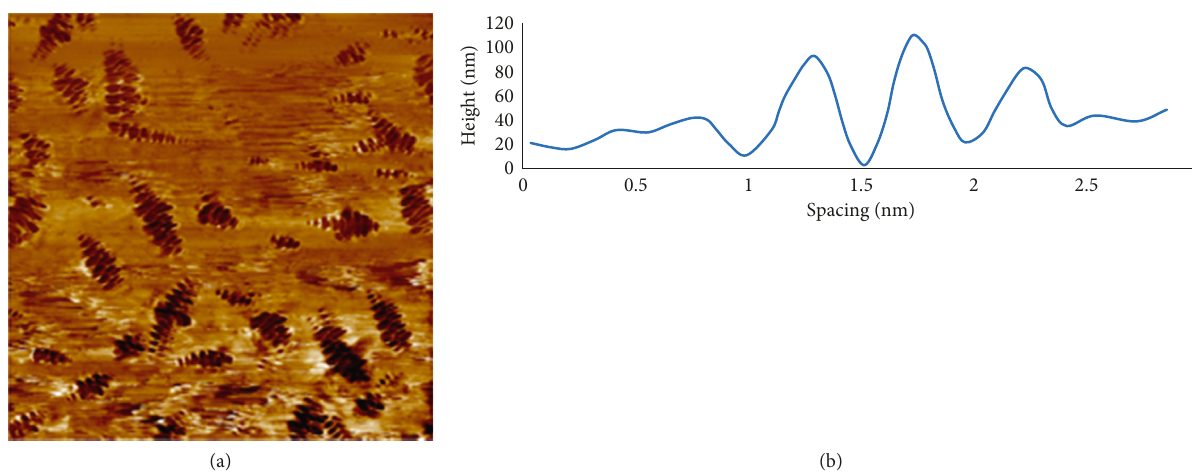
Figure 6: (a) A bird eye view of asphalt sample under AFM, and (b) a tentative topographic profile of bee structure. The Figure 6(b) is reproduced from the data reported by Masson et al. [24] (under the creative commons attribution license/public domain).